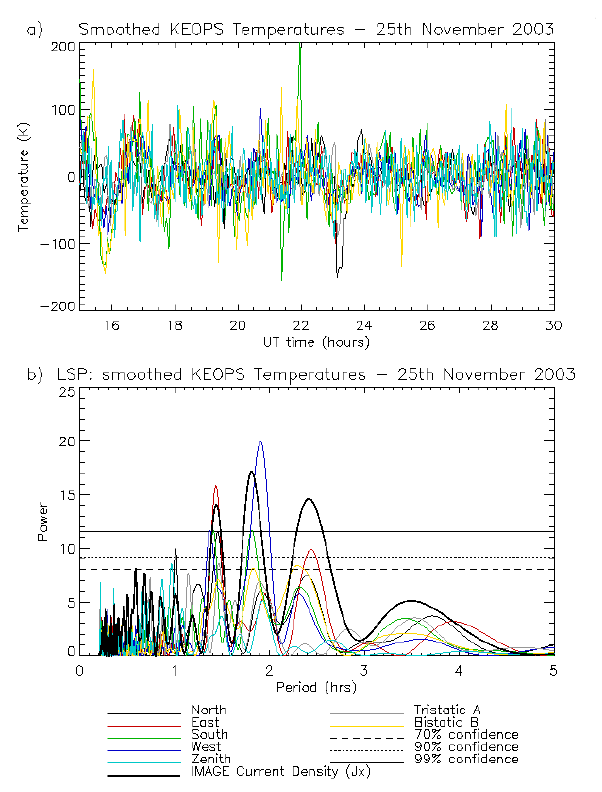
Fig. 3. Neutral temperatures with a 2-h smoothed value removed (a) and their periodogram (b) from KEOPS from 25 November 2003. The bottom plot also shows the periodogram for the equivalent cur- rent densities (thick black line) from IMAGE data (smoothed and reduced by a factor of 2 for comparisons).